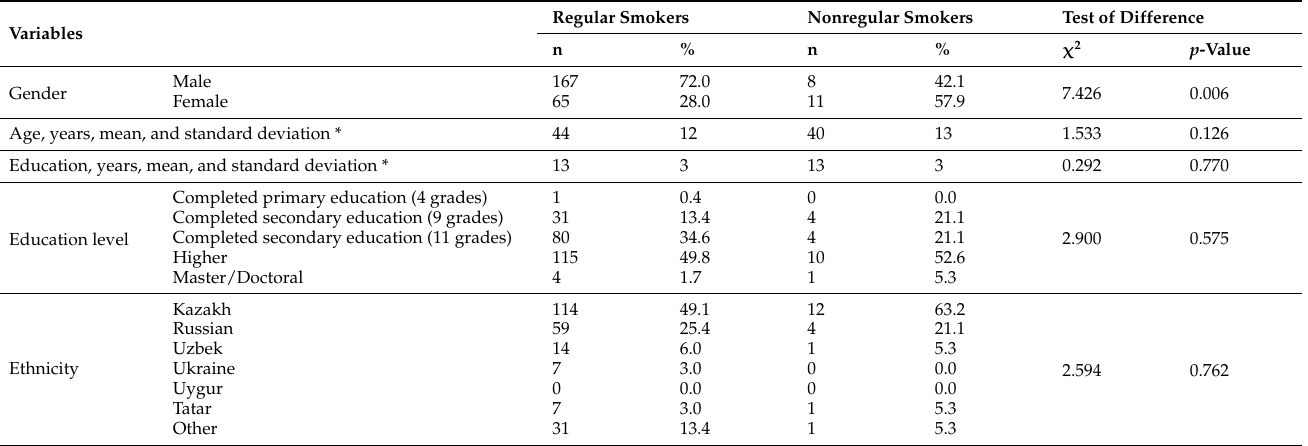
Table 2. Sociodemographic and physical characteristics by pattern of smoking, n =